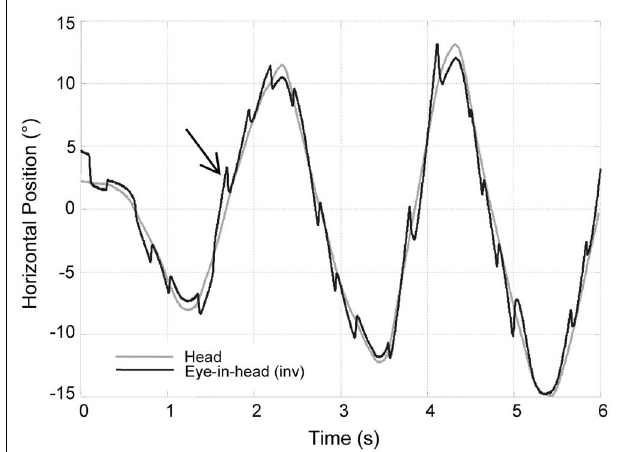
FIGURE 3 | IncreasedVOR gain with cerebellar disease. The inverse of horizontal eye position (black trace) is superimposed on the head position (gray trace) while the patient is fixating on a target during sinusoidal head rotation. Frequent corrective, back up saccades (black arrow) are required to stay on the target and compensate for increasedVOR gain.